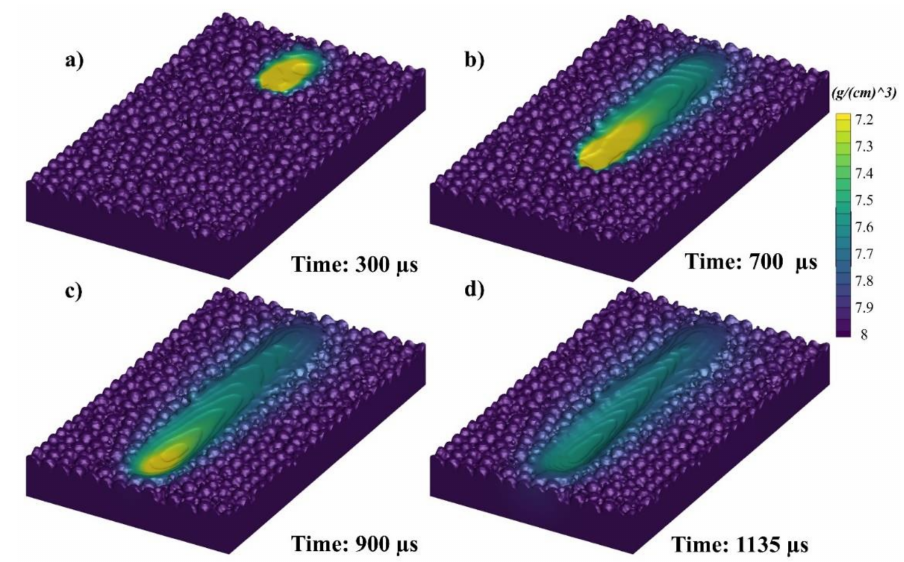
Figure 7. Single track melt pool profile at ( a ) 300, ( b ) 700, ( c ) 900, and ( d ) 1135 µ